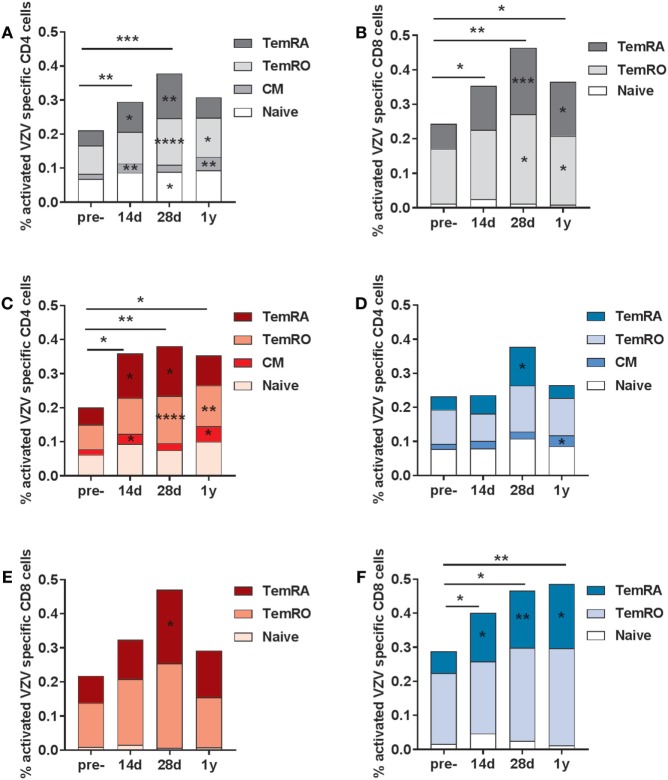
Varicella zoster virus (VZV)-specific activated (CD38+ HLA-DR+) T-cells. The VZV-specific frequency of activated T-cells (based on the double expression of CD38 and HLA-DR) in the CD4 (A) and CD8 (B) T-cell compartments in the total group of participants (N = 20). The VZV-specific activated CD4 T-cells in participants with low (C) and high (D) pre-cell-mediated immunity (CMI). The VZV-specific activated CD8 T-cells in participants with low (E) and high (F) pre-CMI. The geometric mean values were used in the graphs. The different time points were compared with the pre-vaccination frequencies with the Wilcoxon signed rank test preceded by the Friedman test. The stars in the bars indicate significant differences for specific subsets as compared with the pre-vaccination levels, whereas the starts above the bars indicate differences in the total CD4+ of CD8+ VZV-specific activated cells as compared with the pre-vaccination time point. *p < 0.05, **p < 0.01, ***p < 0.001, and ****p < 0.0001.